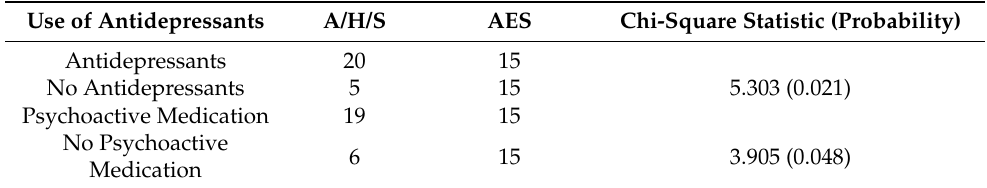
Table 6. A/H/S versus AES comparisons.